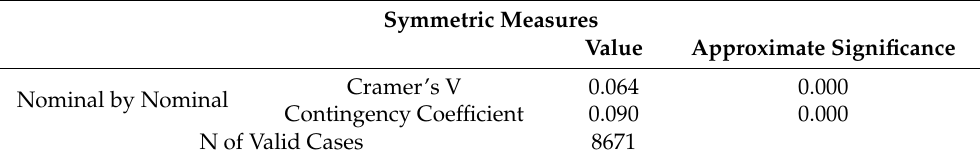
Table 24. Strength of dependence between variables. Source: own